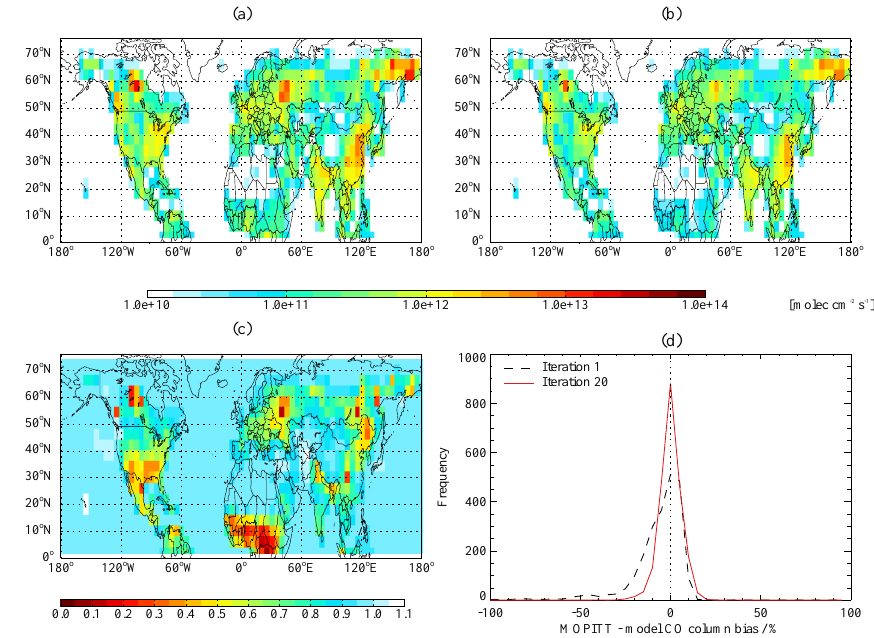
Fig. 11. Mean Northern Hemisphere a priori and a posteriori CO emissions from all sources and scaling factors derived from the assimilation of MOPITT V4 CO observations for July 2010. Plots (a) and (b) respectively show the a priori and a posteriori CO emissions and plot (c) shows the scaling factors. Plot (d) shows histograms of the mean MOPITT minus model biases averaged over the northern extra-tropics for the first (black dashed line) and twentieth (red solid line) iterations of the MOPITT